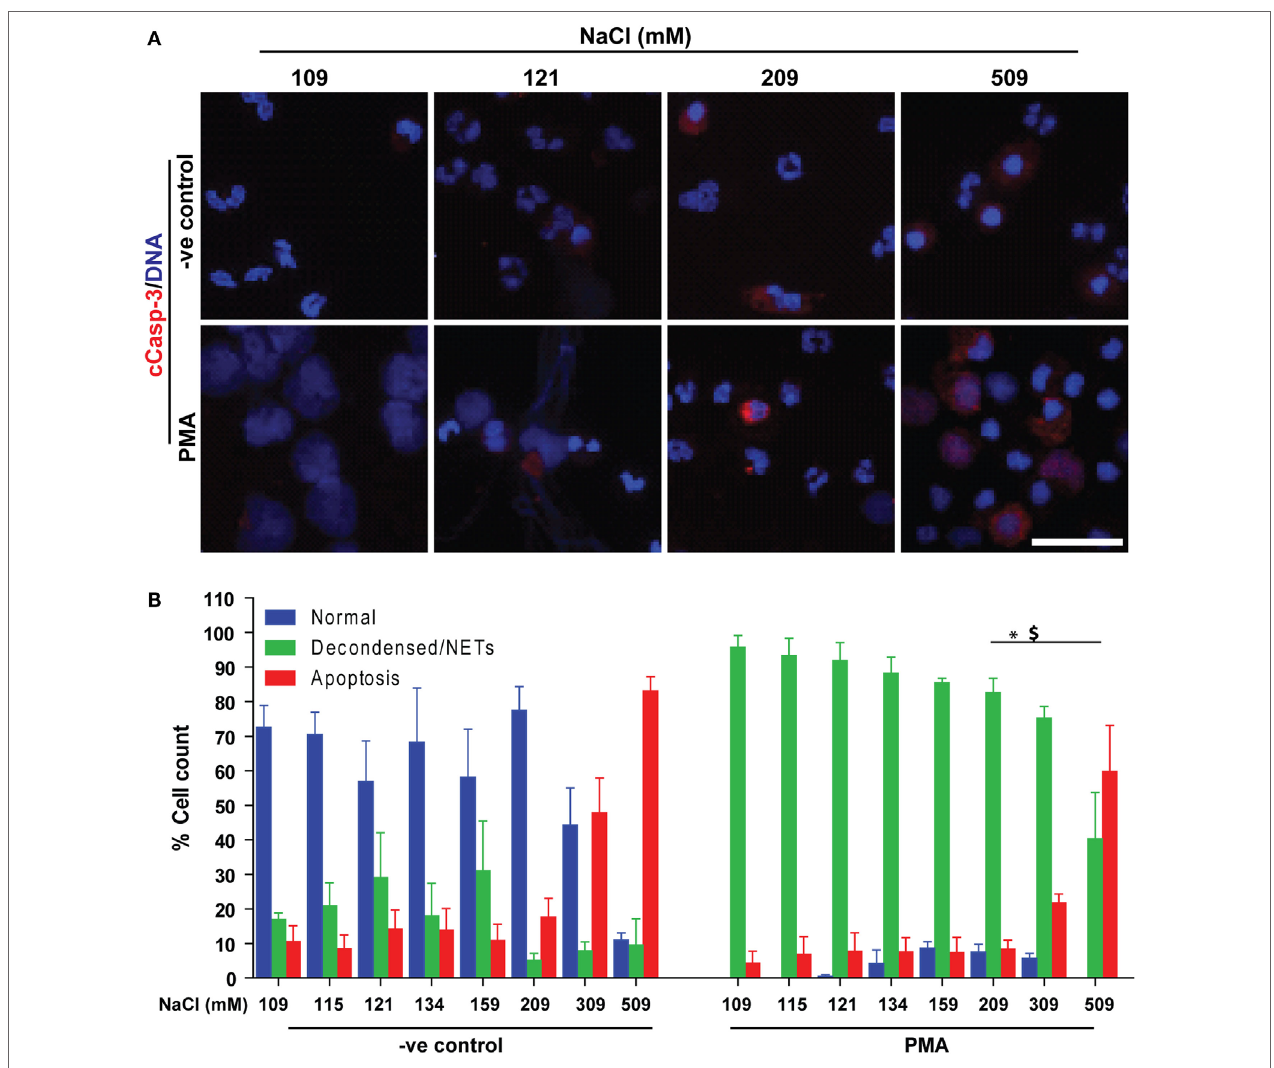
FigUre 7 | Increasing NaCl switches phorbol myristate acetate (PMA)-mediated NETosis to apoptosis. Human neutrophils were either unstimulated ( − ve control) or activated by PMA, and immunostained with DAPI (DNA) and cCasp-3 in different salt concentration conditions (109, 115, 121, 134, 159, 209, 309, and 509 mM). (a) Confocal microscopy of unstimulated ( − ve control) neutrophils show few apoptotic neutrophils at higher NaCl concentrations, but not lower ones. PMA-treated neutrophils with normotonic NaCl treatment undergo complete NETosis. During the hypertonic conditions, NETosis is suppressed, and the cells appear apoptotic ( n = 3; cCasp-3; red, DNA; DAPI, scale bar, 22 µm). (B) % total cell count (based on the immunostaining and cellular morphology) data show a clear trend of NETosis suppression during unstimulated and PMA-mediated activation of neutrophils, while apoptosis is promoted with increasing concentration of NaCl. Collectively, data indicate that suppression of NETosis leads to apoptosis at high salt treatments ( n = 3; * p < 0.05; one-way ANOVA with Tukey’s multiple comparison post test). See Figure S8 in Supplementary Material for low magnification